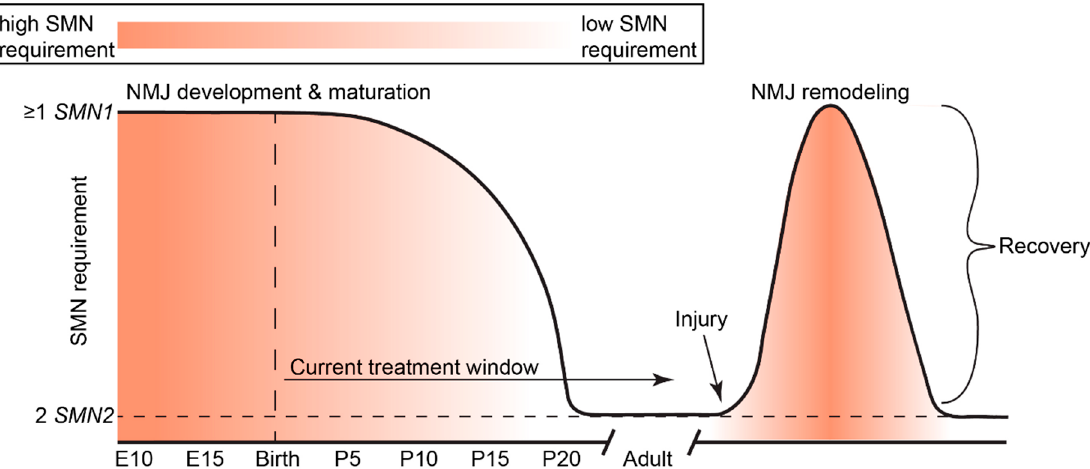
Figure 3. Developmental regulation and requirement of SMN expression in mice. SMN expression is highest during the perinatal period (indicated by an orange to white gradient), but precipitously drops after development of neuromuscular junctions (NMJs; at approximately 17–20 days of age). After the critical period of neuromuscular development, NMJs are viable with low SMN levels. In adulthood, remodeling after injury requires elevated SMN levels to recover and stabilize NMJs. Current therapies for SMA are restricted to the postnatal period. Schematic adapted with permission from Kariya et al., 2014 [85].